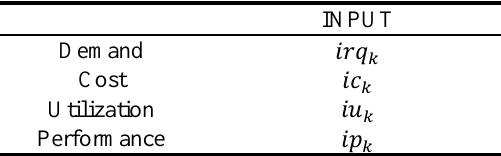
TABLE I. S YMBOLS DEFINITION OF INPUT